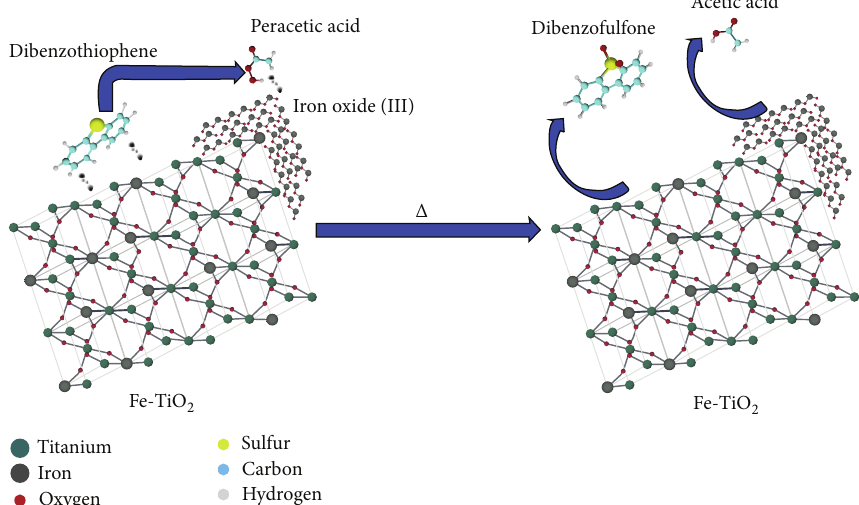
Figure 7: Oxidative removal of dibenzothiophene in a biphasic system using sol-gel Fe/TiO 2 catalysts and H 2 O 2 promoted with acetic acid